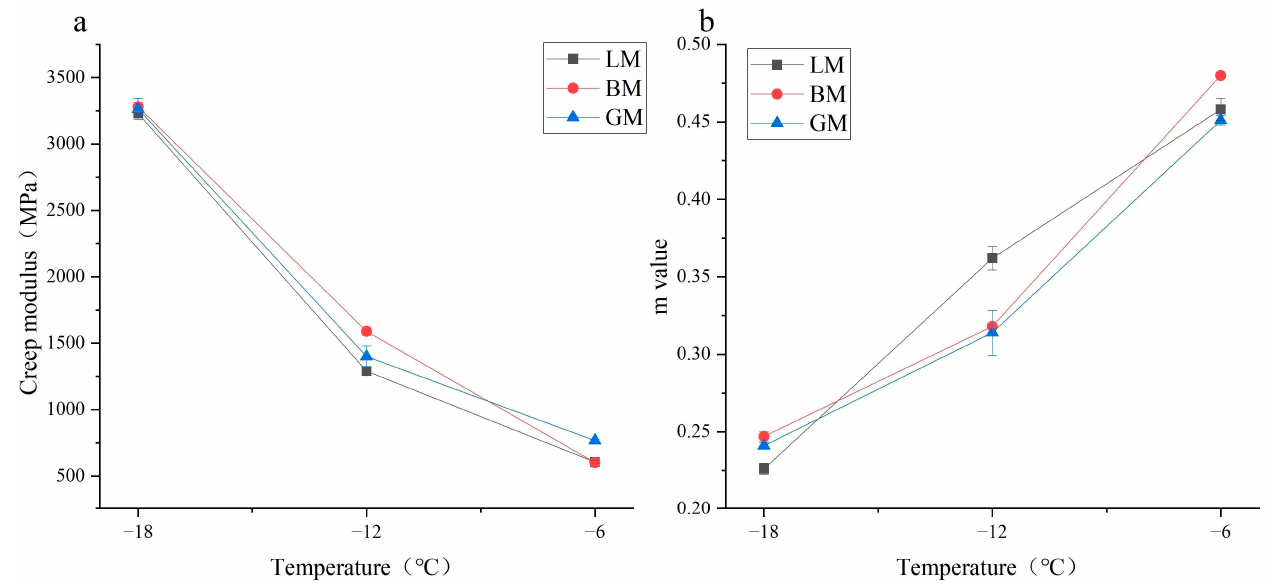
Figure 8. Rheological properties of asphalt mastics at low temperatures: ( a ) stiffness modulus and ( b ) creep rate.